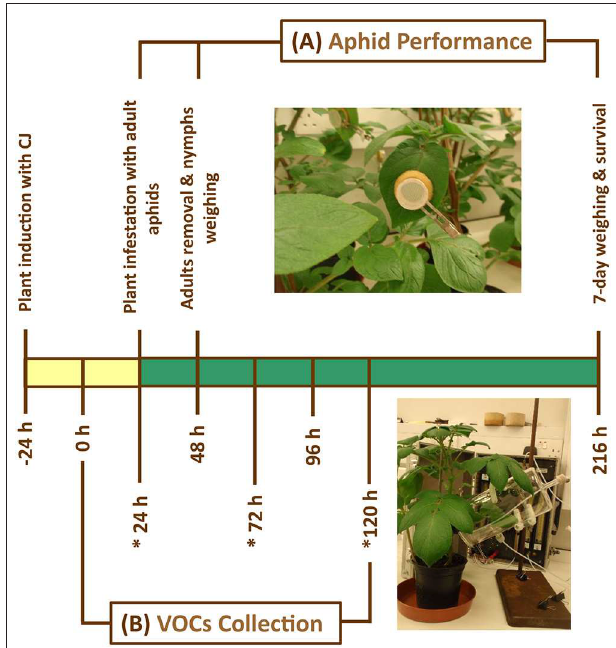
FIGURE 1 | Schematic representation shows the experimental procedure of Macrosiphum euphorbiae performance on potato plants which were allocated randomly to one of the following treatments: (i) Control = untreated plants, (ii) CJ = cis -jasmone-treated plants, and (iii) SUR = surfactant-treated plants. Plants were sprayed and kept separately. (A) Aphid performance assay was carried out 48 after plant treatment. (B) Volatile collection from potato plants was carried out 24 after plant treatment for 5 days in 24h period. (*) refers to the volatile organic compound (VOC) collection periods that were used in this study. Yellow bar indicates when plants were induced with CJ, whereas green bar indicates when plants were fully primed. The used compound leaves for both experiments were identical in their height and position on the stem of potato